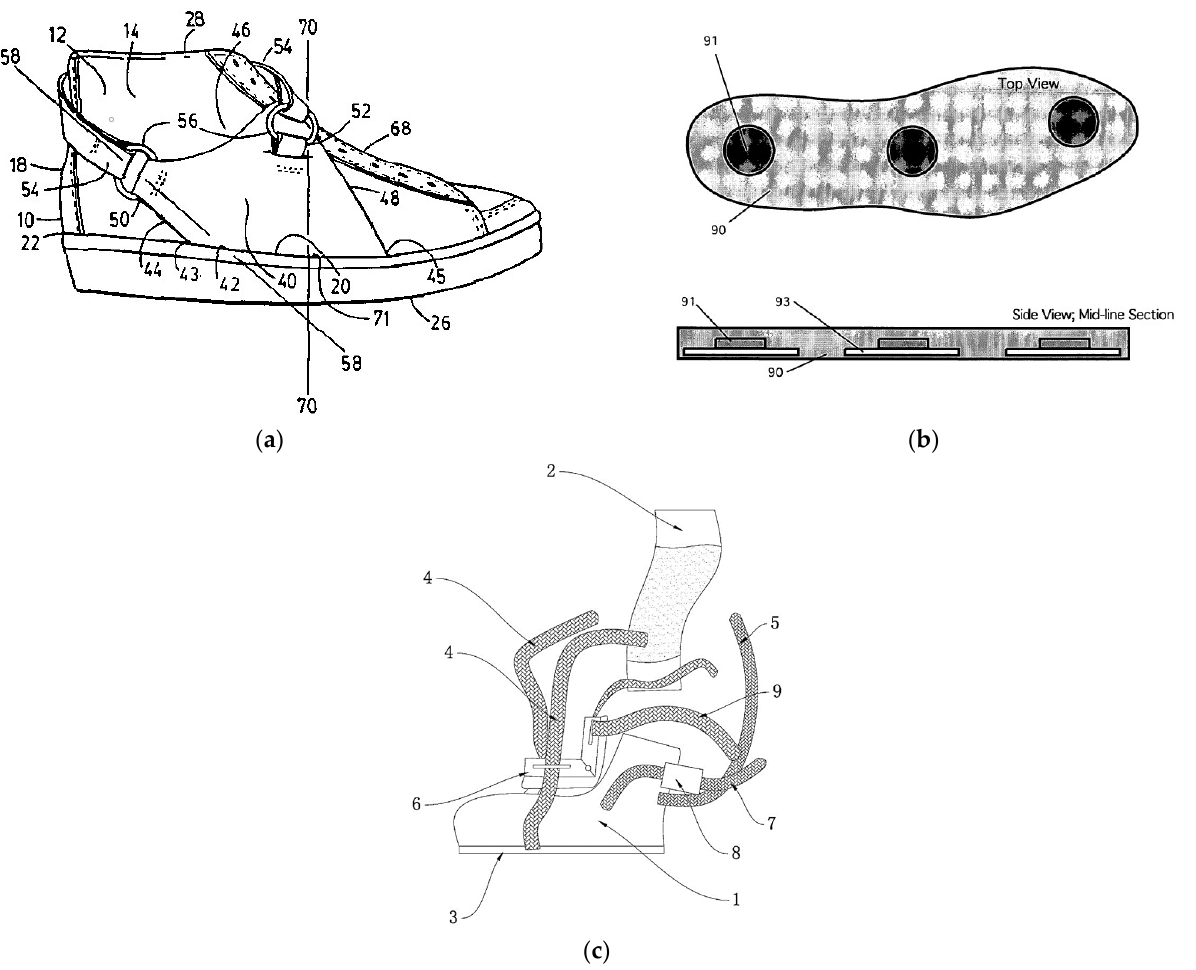
Figure 12. Patents of general use Orthosis: ( a ) Shoe with Ankle Protector [61], ( b ) Method and Apparatus for Improving Human Balance and Gait and Preventing Foot Injury [62], and ( c ) Temporary Moulding Sock for outdoor sprain and using method thereof [48].